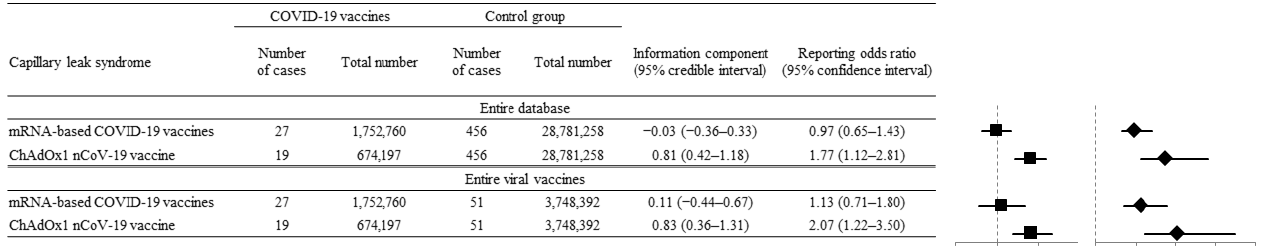
Figure 3. Disproportionality analysis using data reported by physicians and other healthcare professionals only. Forest plot with the reporting odds ratio (ROR, diamonds) and information component (IC, squares) values of mRNA-based (BNT162b2, mRNA-1273) and ChAdOx1 nCoV-19 vaccine-associated SCLS versus those from the entire database and all recorded viral vaccines. The ChAdOx1 nCoV-19 vaccine showed a significantly positive association with SCLS by IC 025 of 0.81 (95% CI, 0.42 – 1.18) and ROR 025 of 1.77 (95% CI, 1.12 – 2.81).